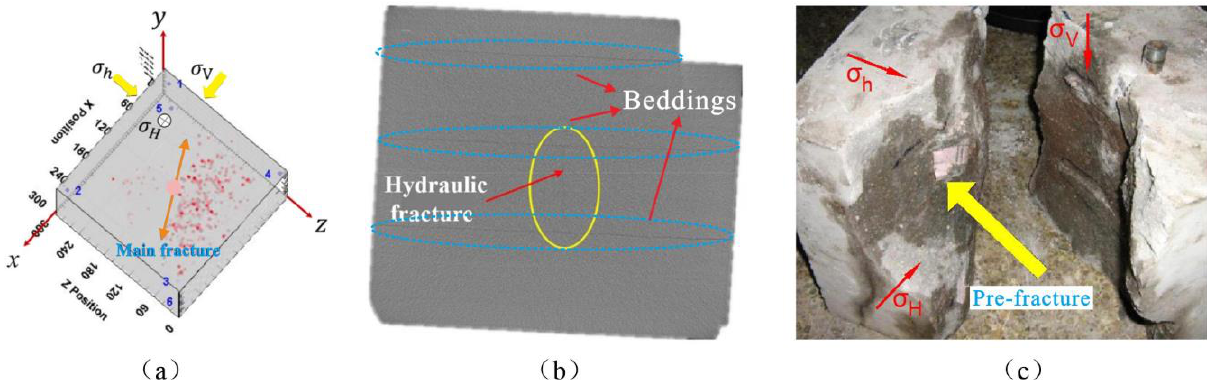
Figure 2. Fracture propagation study assistive technology [58,73,74]: ( a ) Acoustic emission monitor- ing technique, ( b ) CT scanning technique, ( c ) Post-pressure fracture morphology observation.